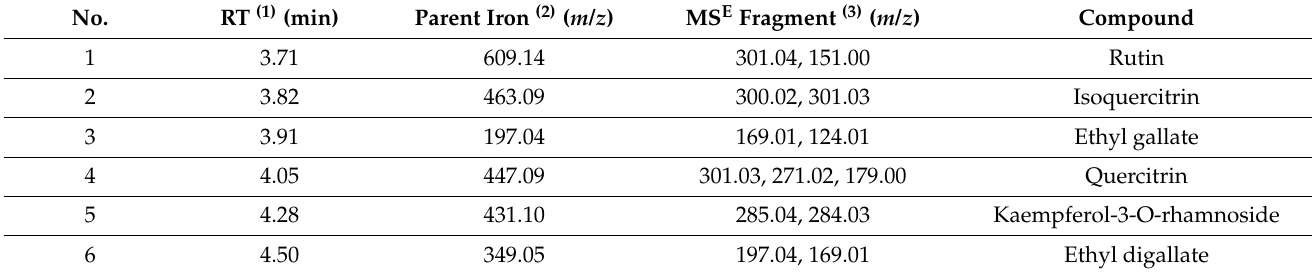
Table 2. Identification of main compounds of ethyl acetate fraction from Cedrela sinensis (EFCS).